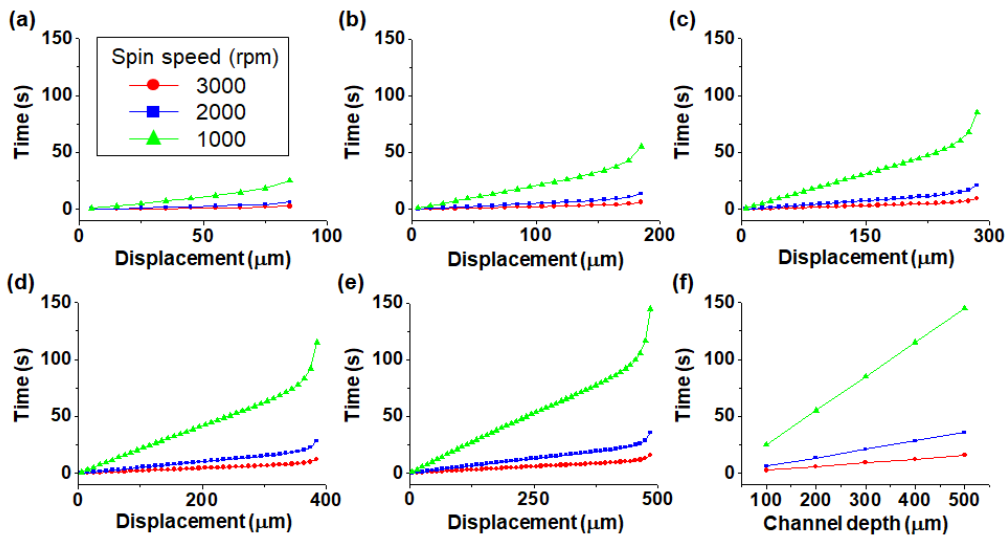
Figure 5. Plots of time–displacement for channel depths of ( a ) 100 µ m, ( b ) 200 µ m, ( c ) 300 µ m, ( d ) 400 µ m and ( e ) 500 µ m; ( f ) Time taken by particles to reach the top of the channel depending on channel depth (h = 15 µ m).